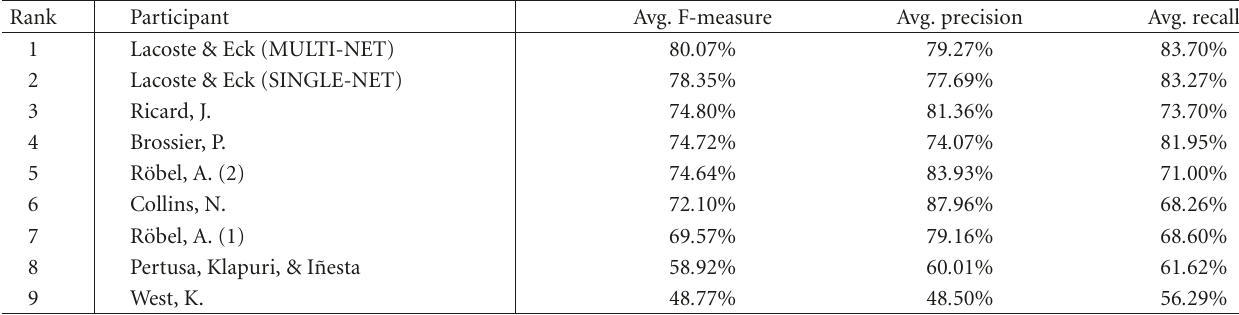
Table 6: Overall scores from the MIREX 2005 audio onset detection contest. Overall average F-measure, overall average precision, and overall average recall are weighted by number of files in each of nine classes.